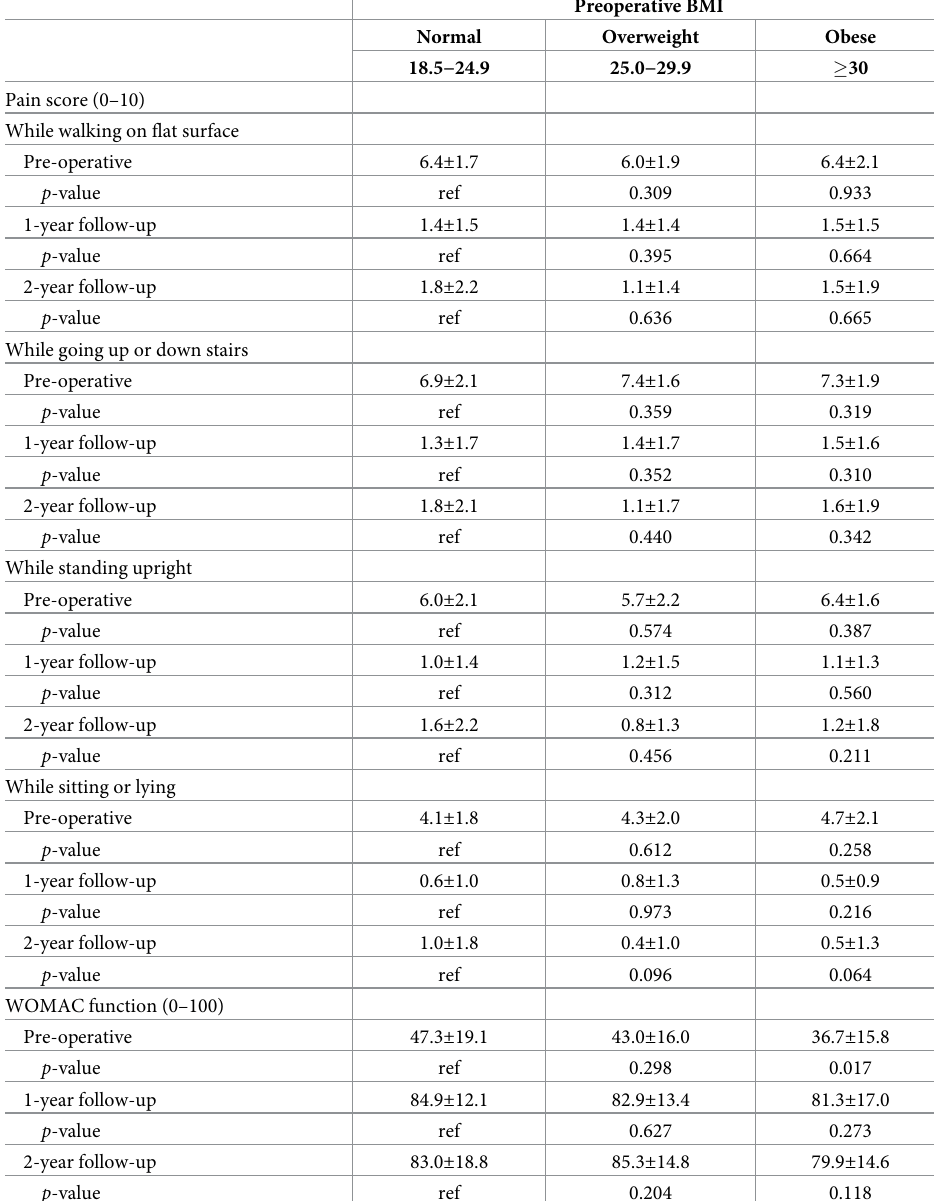
Table 2. Clinical